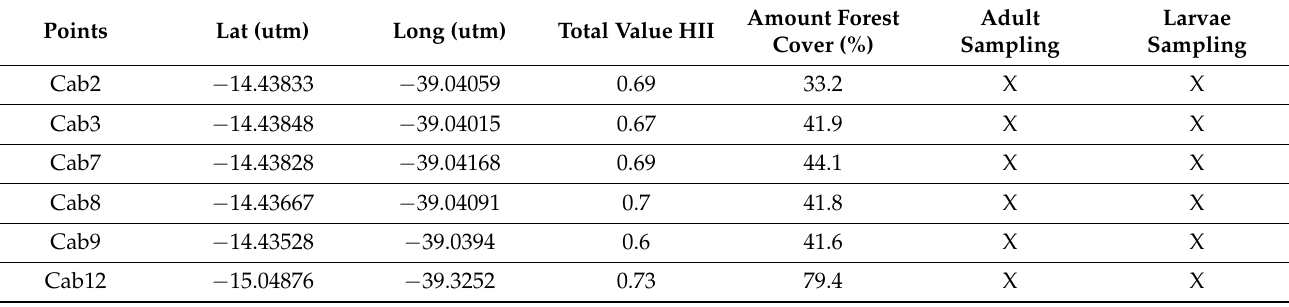
Table A1. Geographical coordinates of sites sampled in cocoa-growing areas in Bahia. Total value of the habitat integrity index (HII). Information on the sampling of adults and/or larvae at each of the sites